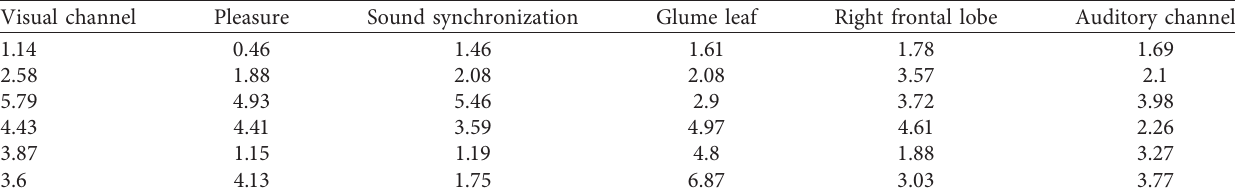
Figure 8: EEG synchronicity index of happy emotion cognition. Table 8: Synchronized oscillation phenomenon.